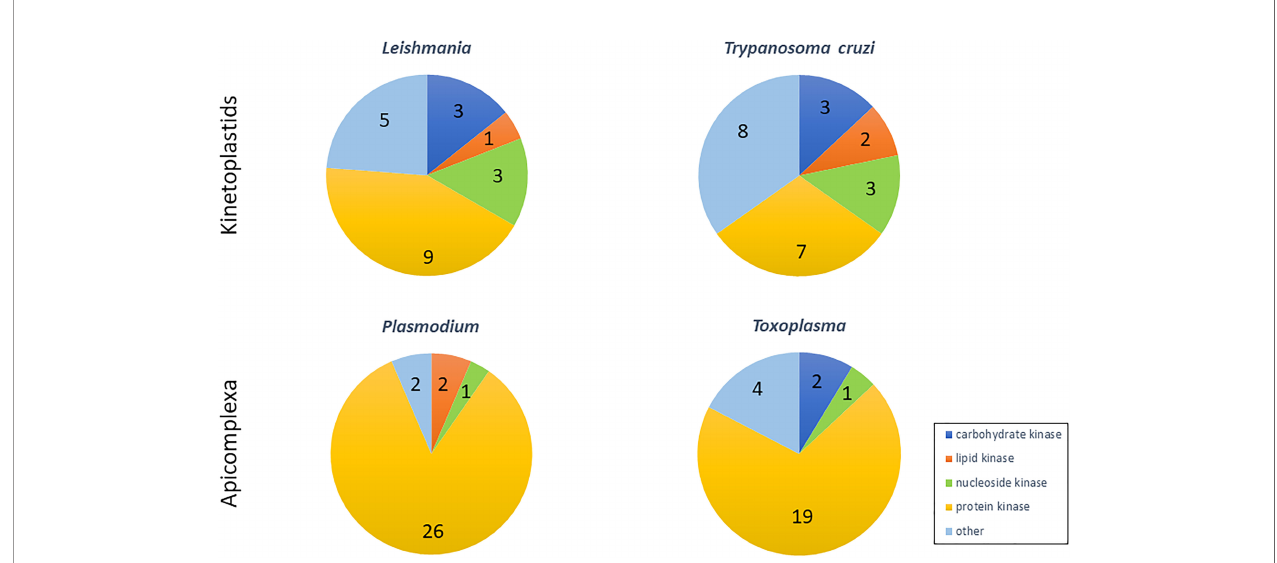
FIGURE 1 | Proportion and number of kinases classes according to their substrates, identi fi ed in secretome of Kinetoplastids ( Leishmania and Trypanozoma ) and Apicomplexa ( Toxoplasma and Plasmodium